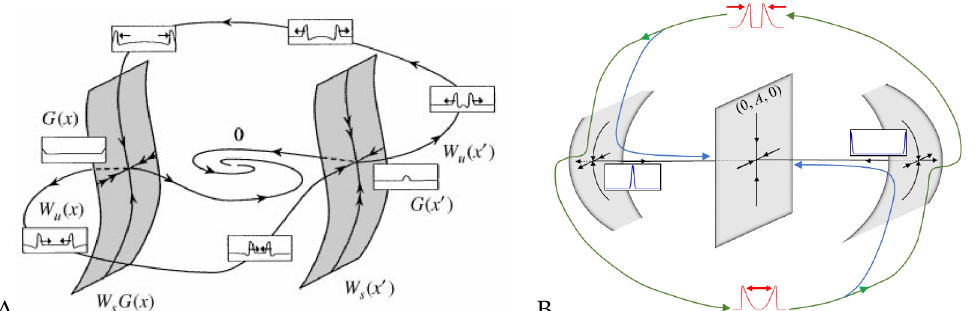
A B Figure 4. Excitable solitons, geometric schematics of the dynamics during collision of two pulses. ( A ) FitzHugh–Nagumo model and ( B ) an reaction–diffusion model with mass conservation, of Equation (5) type. ( A ) Reprinted from Publication [173], with permission from Elsevier and ( B ) from [151], Copyright 2020 by the American Physical